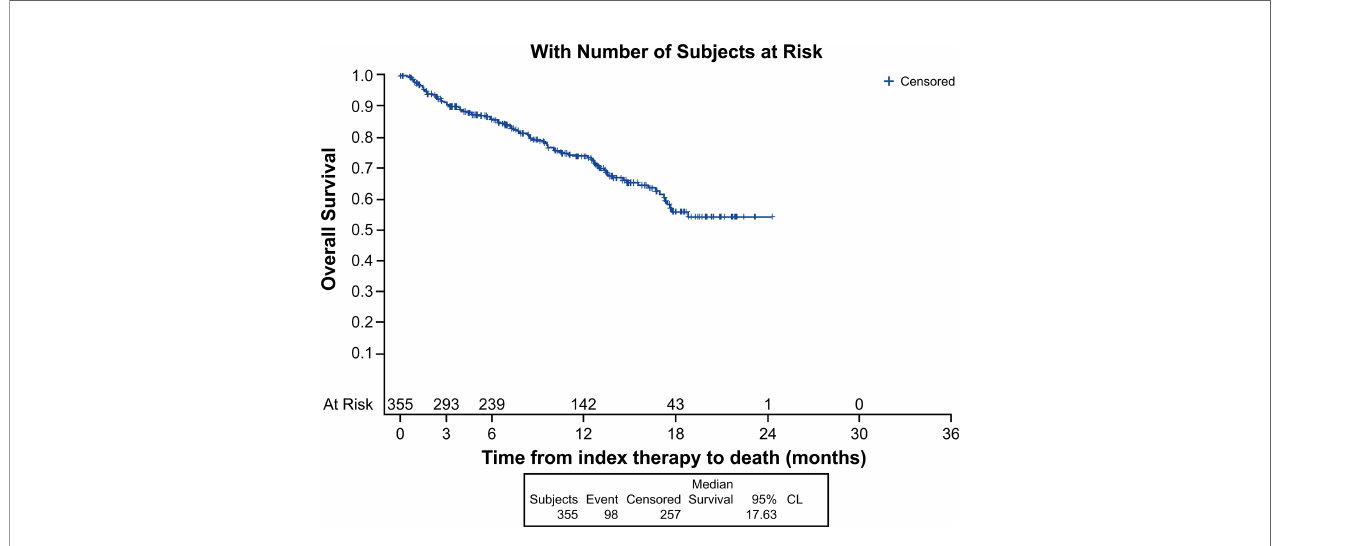
FIGURE 2 | Kaplan-Meier analysis of real-world overall survival.